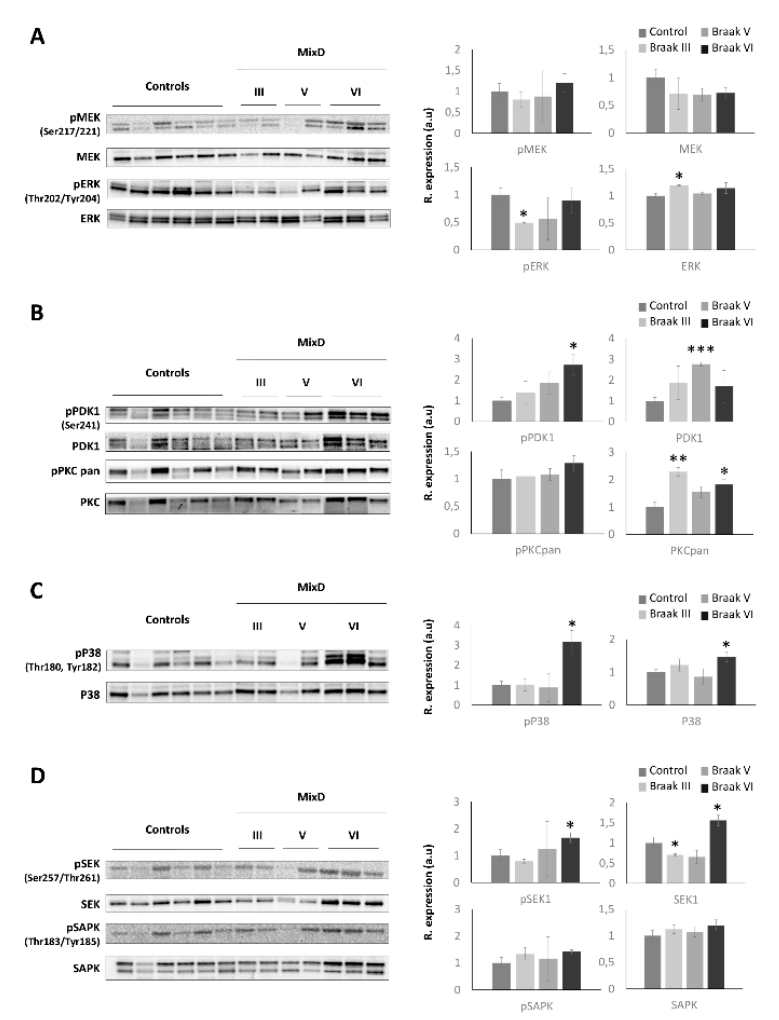
Figure 6. Olfactory expression of survival routes across MixD stages. Levels and phosphorylation of MAP kinases ( A ), PDK1-PKC ( B ), p38 MAPK ( C ), and SEK1-SAPK ( D ). * p < 0.05 versus control group; ** p < 0.01 versus control group; *** p < 0.001 versus control